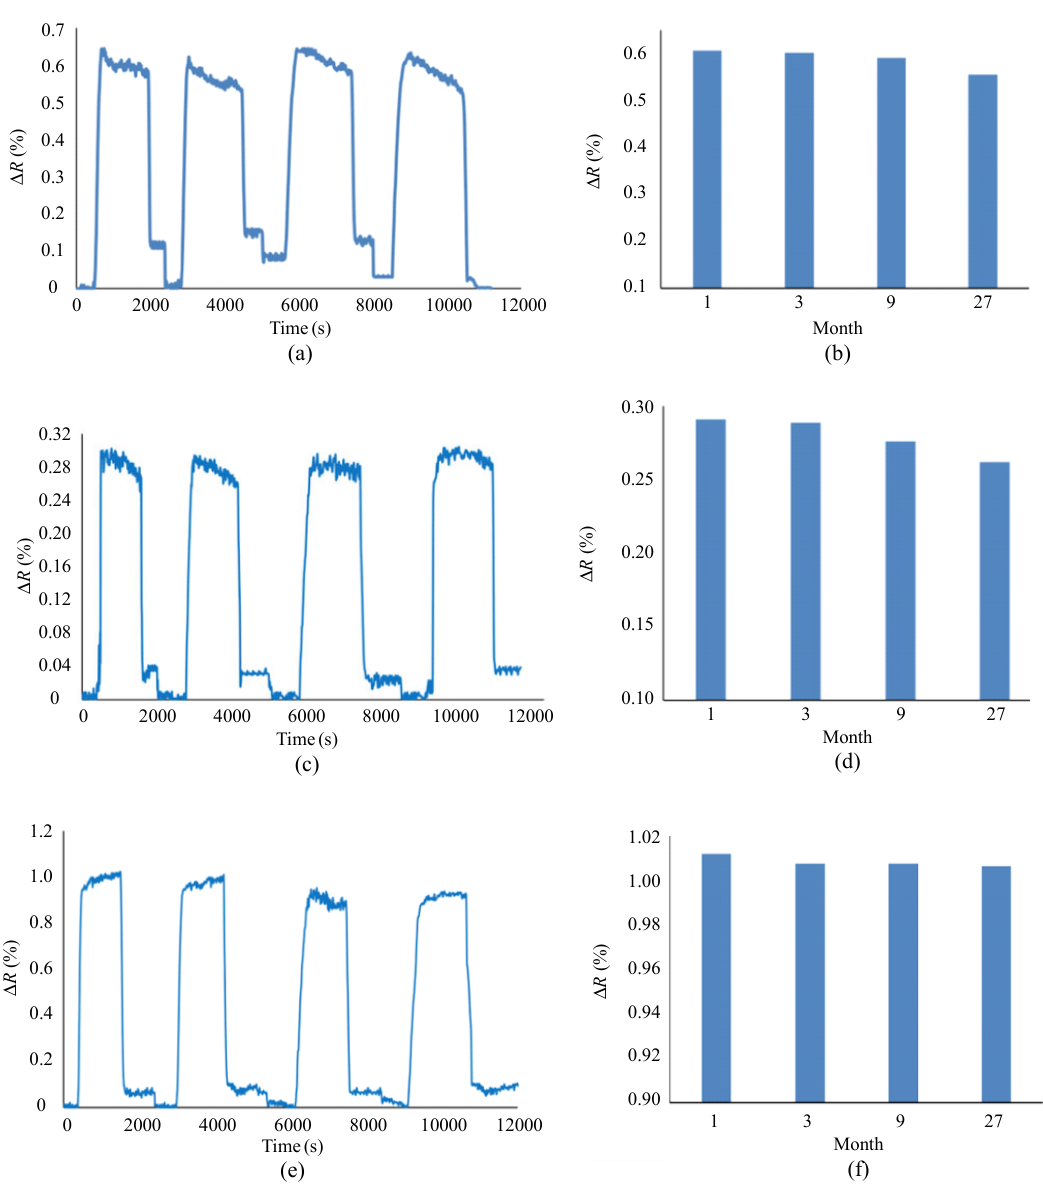
Fig. 9 Reproducibility [(a), (c), and (e)] and storage stability [(b), (d), and (f)] of vitamin B2, B9,and B12 imprinted SPR sensors [(a) and (b): vitamin B2 imprinted SPR sensor; (c) and (d): vitamin B9 imprinted SPR sensor; (e) and (f): vitamin B12 imprinted SPR sensor] ( C vitamin B2 : 0.01 ng/mL, C vitamin B9 : 0.5 ng/mL, and C vitamin B12 : 0.1 ng/mL in all